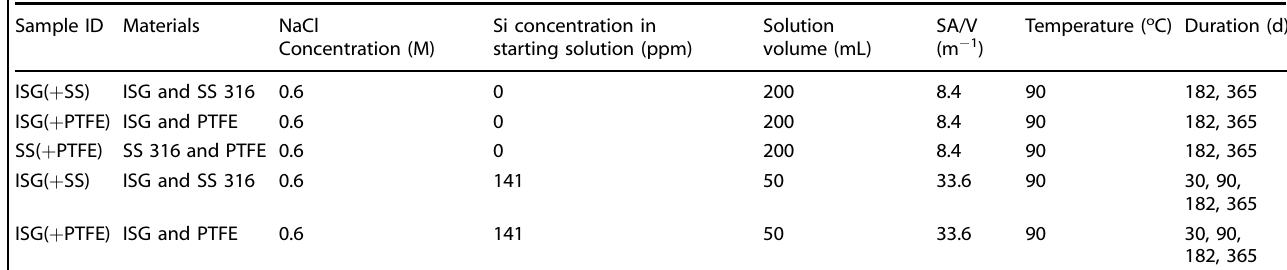
Table 1. List of experimental groups and testing conditions used in the present study. Sample ID